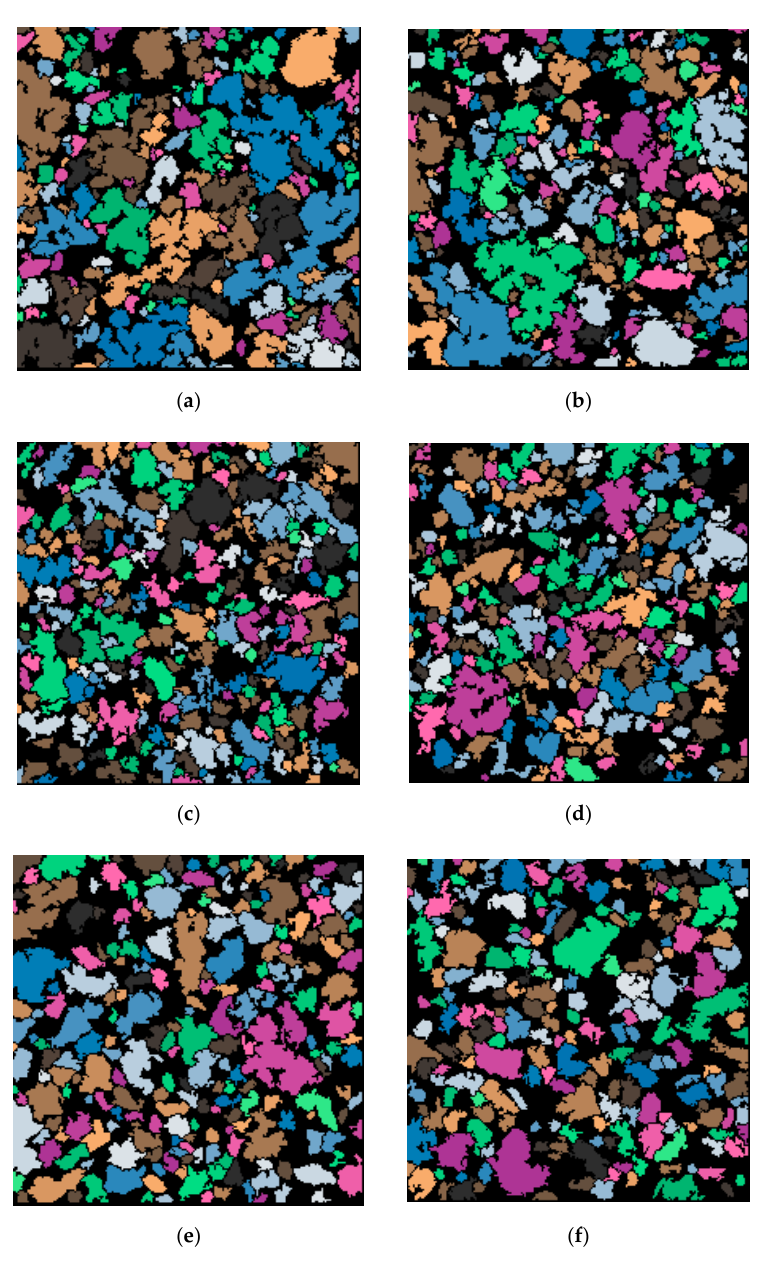
Figure 8. SEM image. ( a ) 0, ( b ) 5, ( c ) 10, ( d ) 20, ( e ) 30, ( f ) 50.